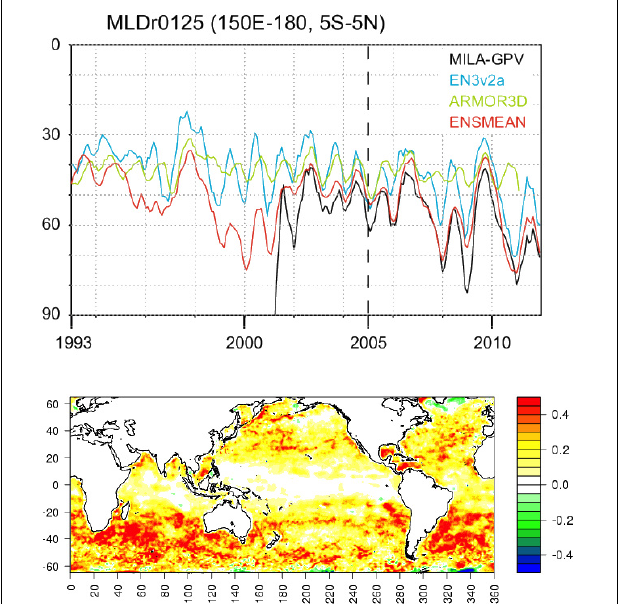
FIGURE 1 | Examples of reanalyses outperforming objective analyses. Top panel, timeseries of mixed layer depth (in meters, using 0.125 Kg m - 3 density criterion) from profile data (MILA-GPV), the ensemble of reanalyses (REAENS) and two statistical objective analyses (EN3v2a, ARMOR3D) in the western Pacific warm pool region. Source: Toyoda et al. (2017). Bottom panel, map of the difference of steric sea level correlation (with respect to independent verifying data) between reanalysis and objective analysis ensemble means. Source: Storto et al. (2017). Image reproduced with permission of the rights